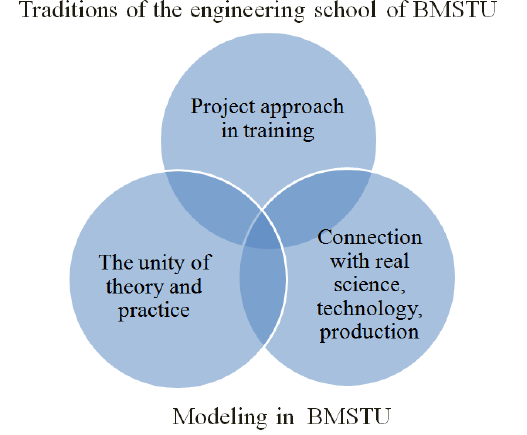
Fig. 4. Engineering school and modeling in BMSTU.